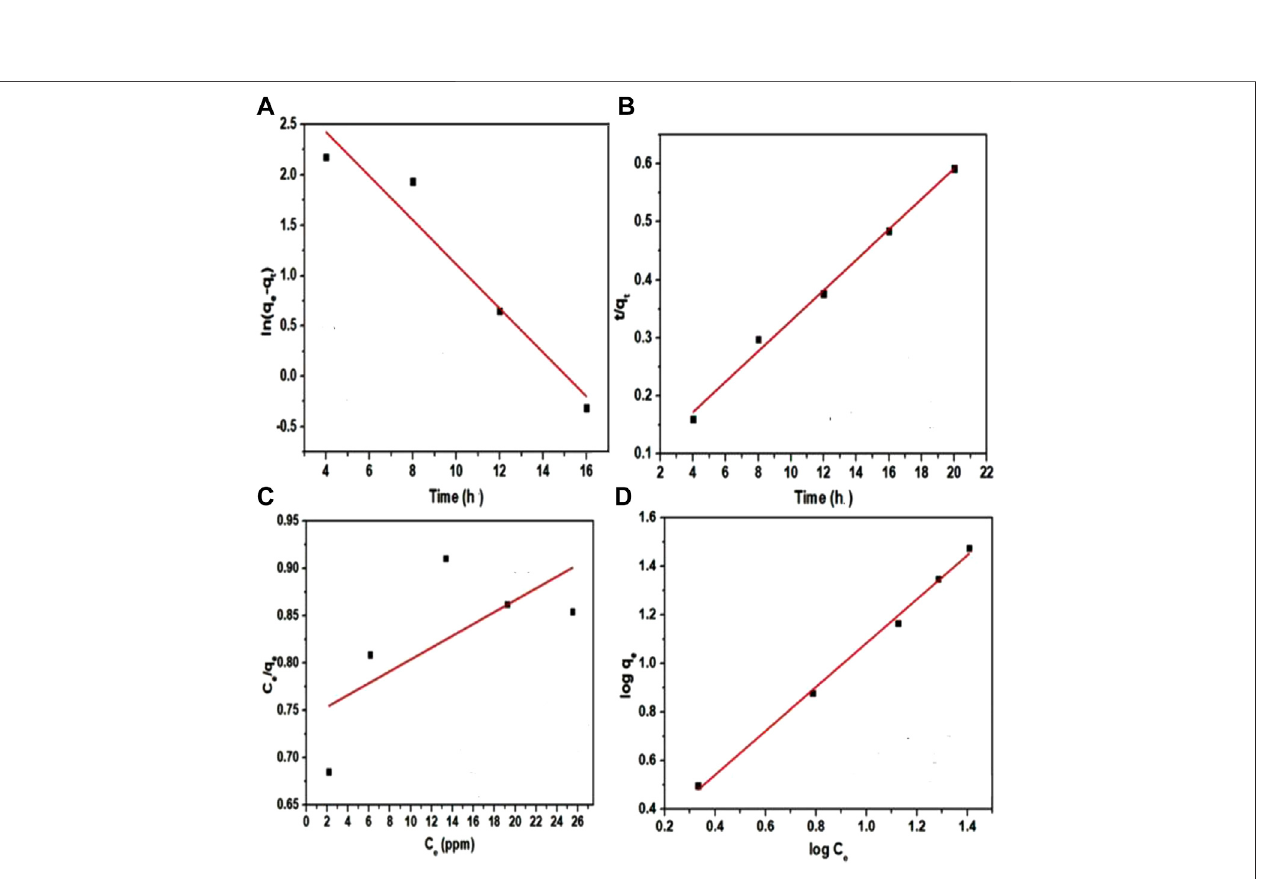
Frontiers in Materials |